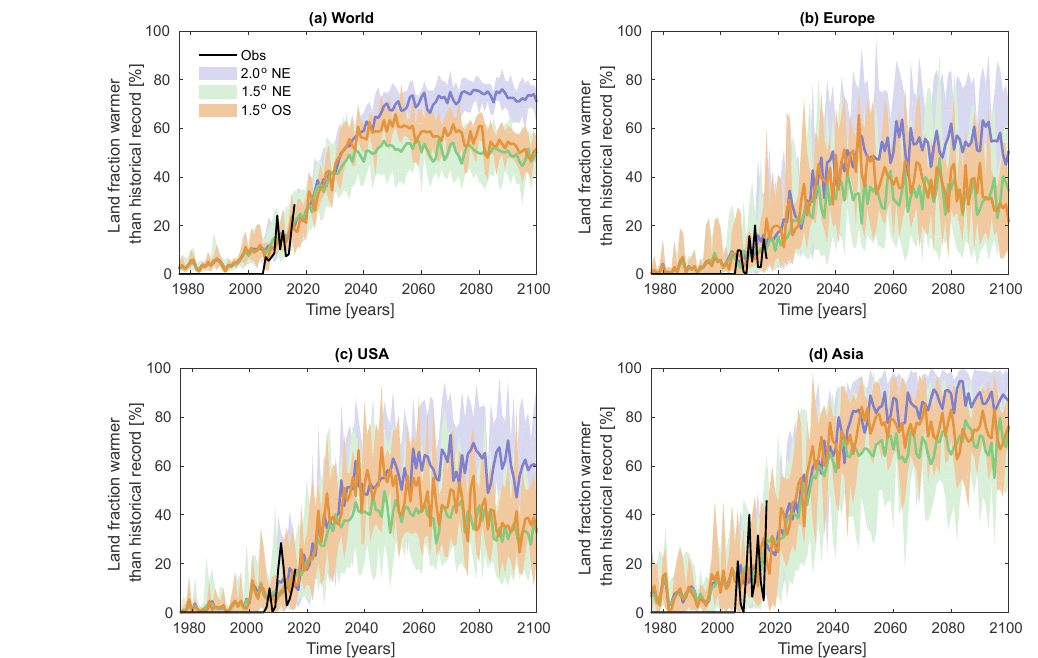
Figure 3. Fraction of land in which the observed historical summer temperature record defined during the period 1976–2005 is broken in any given year. Summer is defined for each grid cell as the climatologically warmest 3-month period. Panel (a) is the fraction of global land area, while (b–d) refer to the fraction of a specific region. The solid central line is the ensemble mean for each scenario, and the shaded areas represent the full ensemble